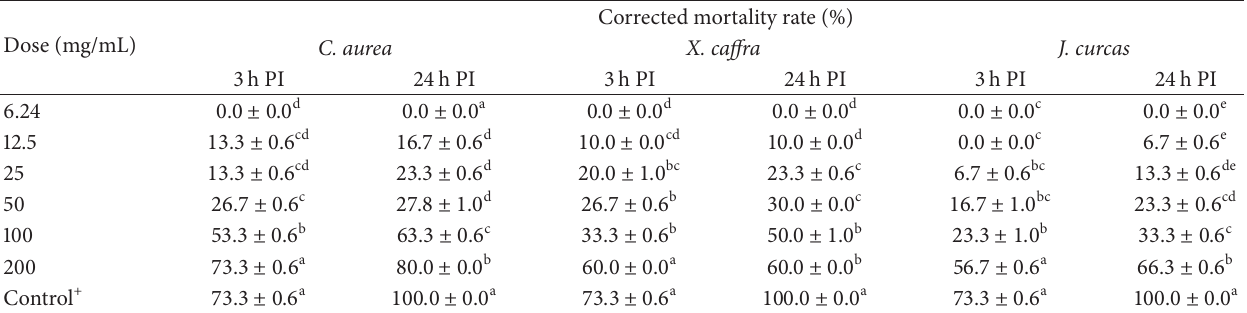
Table 2: The corrected mortalities of M. ovinus sheep keds exposed to different concentrations of aqueous extracts of C. aurea leaves, X. caffra fruits, and J. curcas fruits.